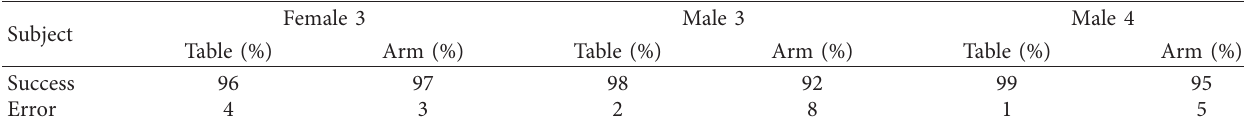
Table 3: Initial testing results by three people (bare